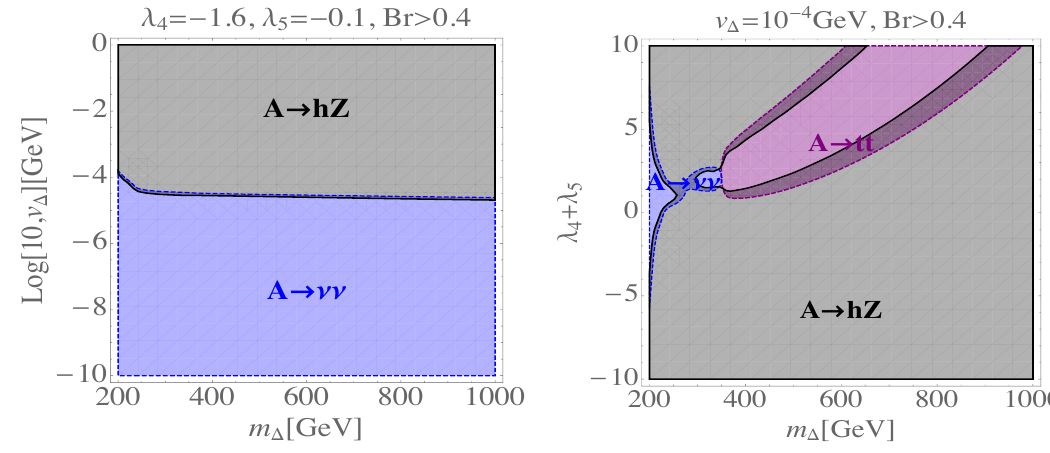
Figure 13 . Decay region plots for A with BR (cid:21) 40%. Black region for the hZ channel, purple region for the t quark pair channel and blue region for the di-neutrino